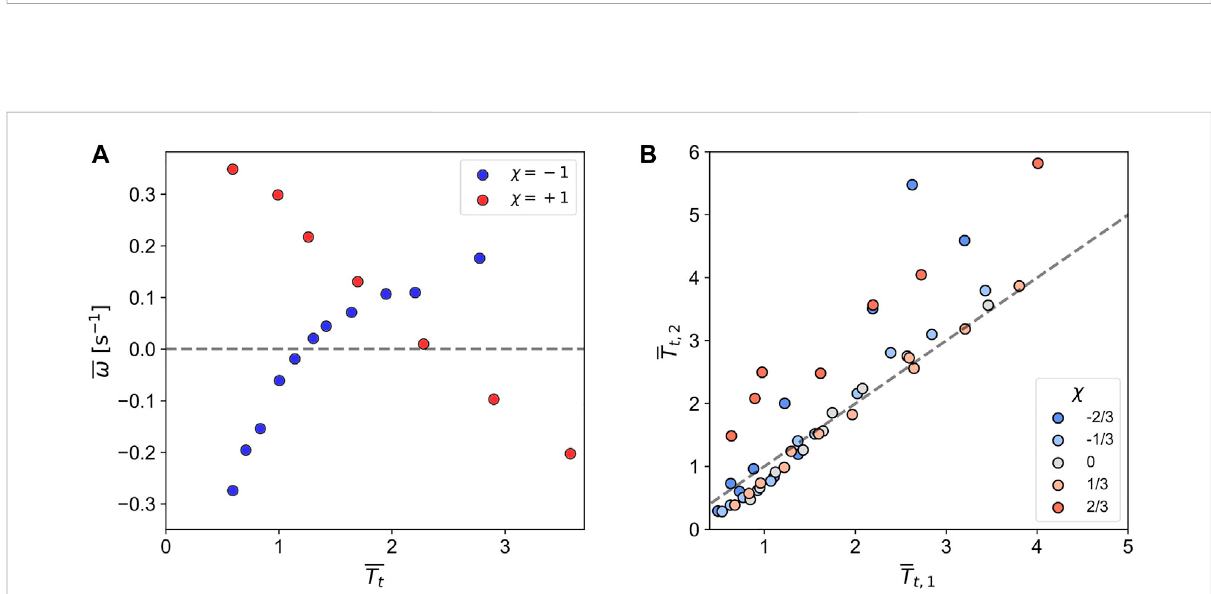
FIGURE 5 (A) General trend of the chirality for the two single-component cases. (B) Mean kinetic energy for both species; type-2 disks tend to show a higher activity level for the same energy input despite our efforts to consistently fabricate both